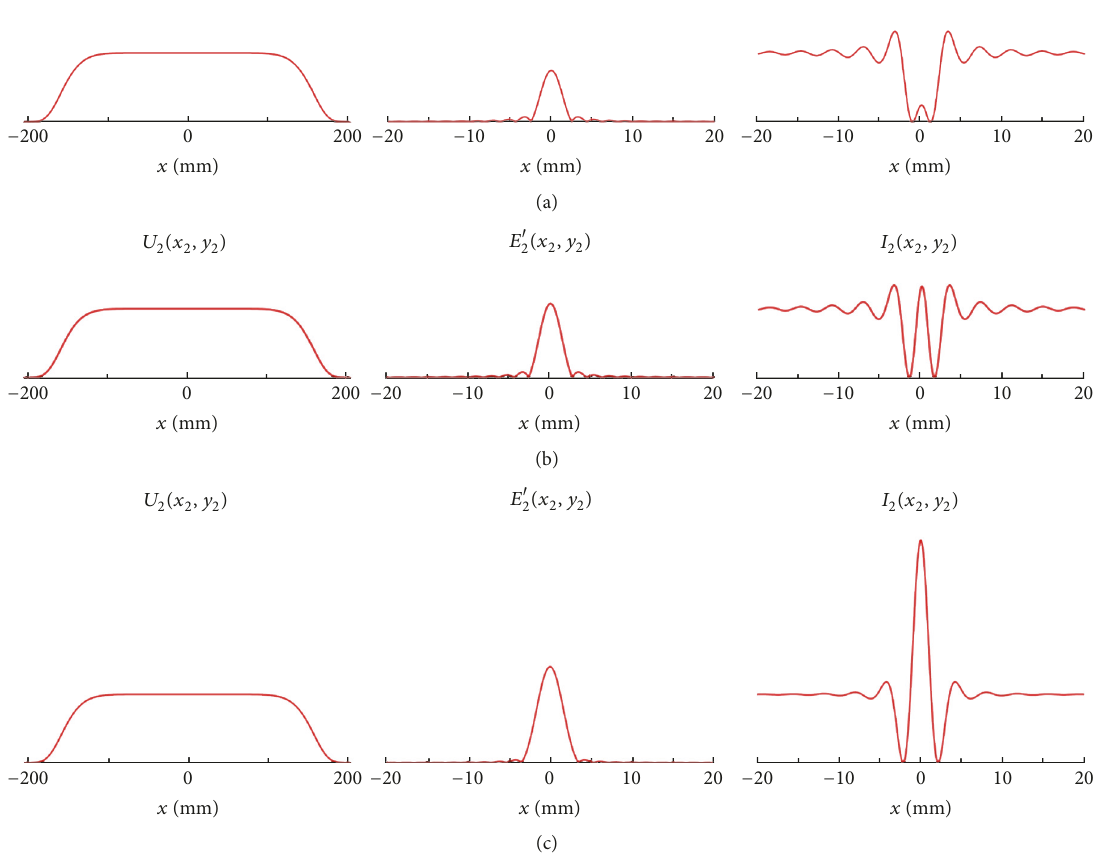
Figure 3: Intensity profiles at image relay plane. (a) R = 1.5mm, (b) R = 2.1mm, and (c) R = 3.2 mm.